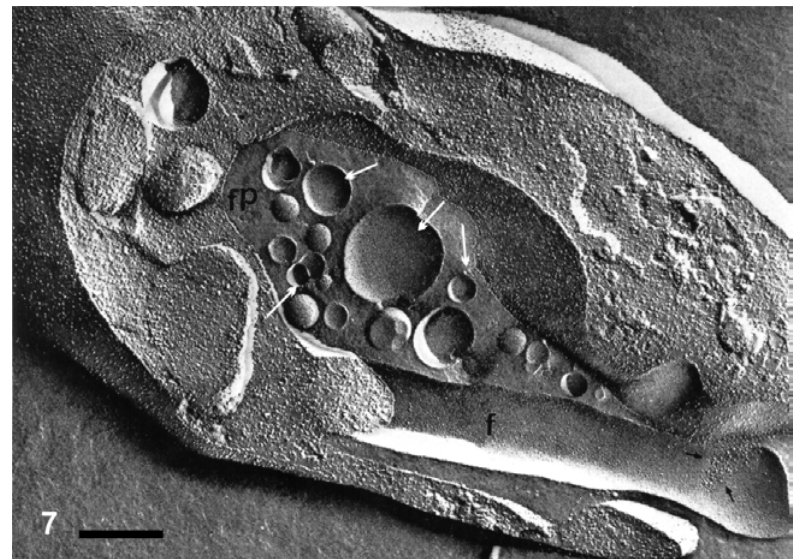
Fig. 7 – Freeze-fracture view of the anterior region of a promastigote forms of Herpetomonas . A large number of vesicles (arrows) are seen within the flagellar pocket (FP). F, flagellum. Small arrows point to an aggregation of intramembranous particles, which form the flagellar-cell body adhesion structure. Bar, 0.12 µ m. After De Souza et al. 1979.